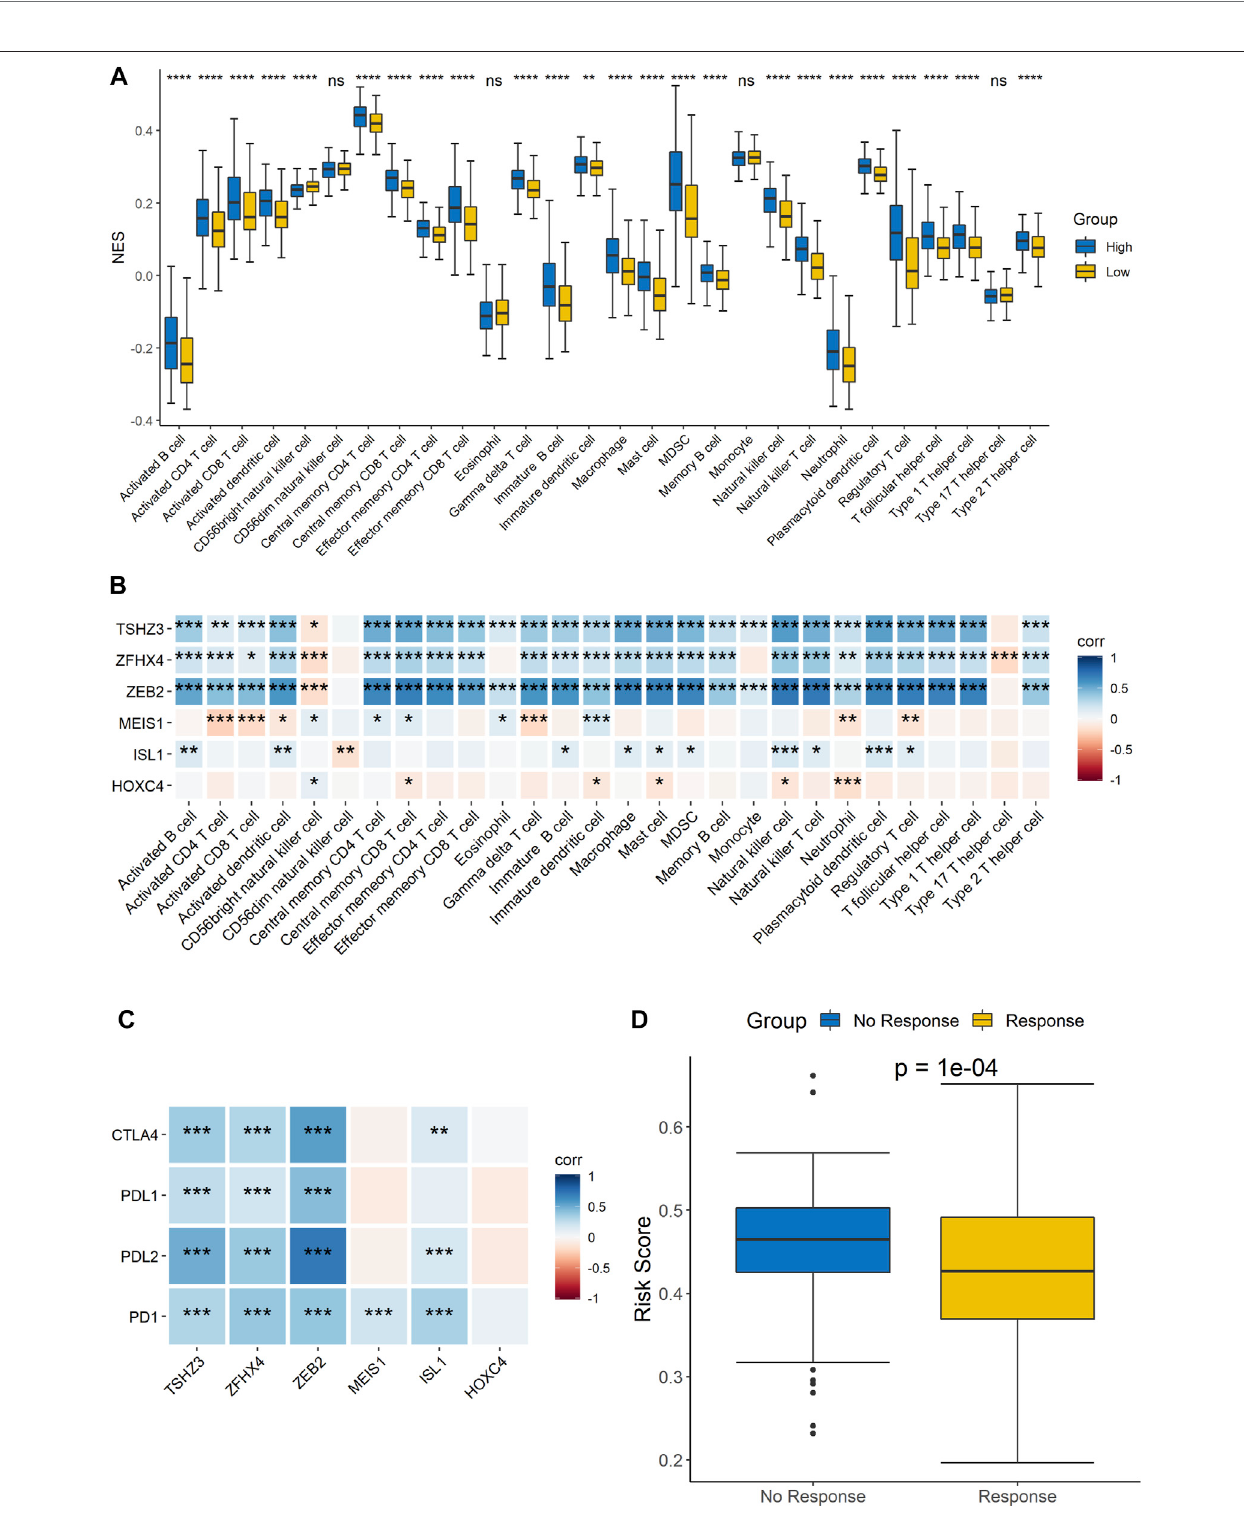
FIGURE 6 | Correlation analysis of the signature and immune characteristics. (A) Correlations between the signature and each immune cell in fi ltration score. (B) Correlations between each signature gene and each immune cell in fi ltration score. (C) Correlations between the expression level of immune checkpoints and the six signature genes. (D) Prediction of the difference in risk scores between immunotherapy responders and non-responders.